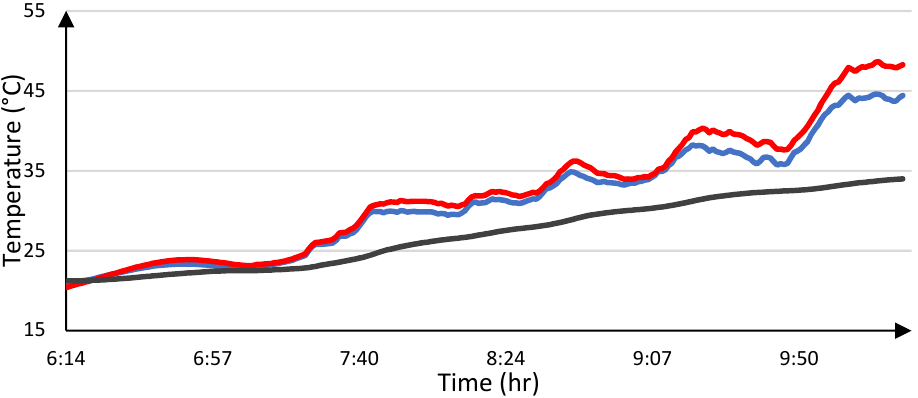
Figure 12. Deviation between the reference case and the enhanced panel. The different performances resulting during the daytime hours, made a greater deep- ening necessary. An analysis was differentiated in the function of the state of the PCM, to find a correlation. Figures 13–15 show the temperature difference in the two systems with solid state PCM, during phase change and liquid phase, respectively. The red line indicates the front temperature of the simple panel, while the blue one the enhanced panel. The black line is the average of the two thermocouples dipped into the PCM, to measure the thermal level of the PCM.